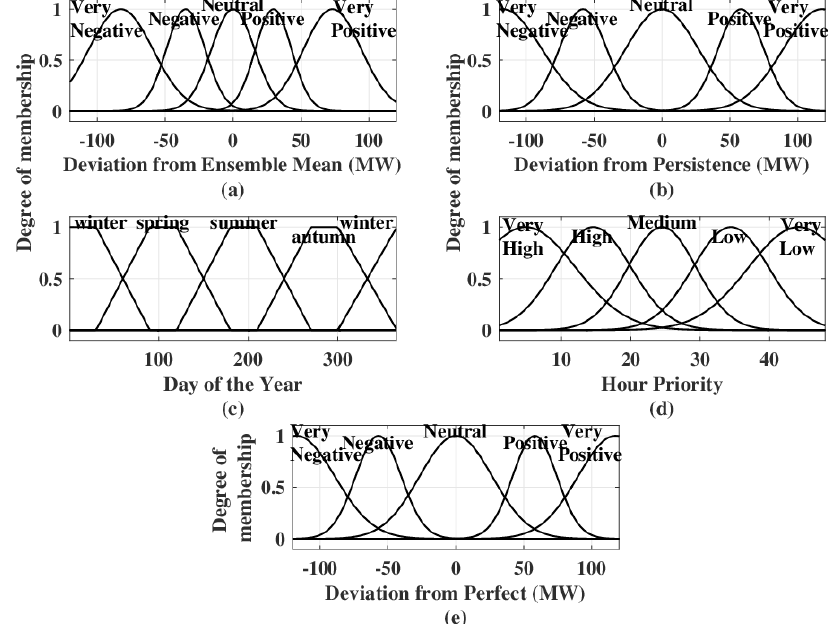
Figure 7. Example of classes’ definition for the parameters deviation from ensemble mean ( a ), deviation from persistence ( b ), day of the year ( c ), hour priority ( d ) and deviation from perfect ( e ).